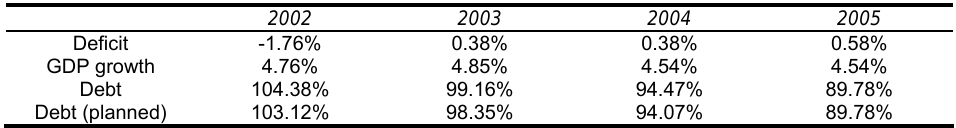
Table 9. Italian government deficit plan after a one-time deviation and revision in